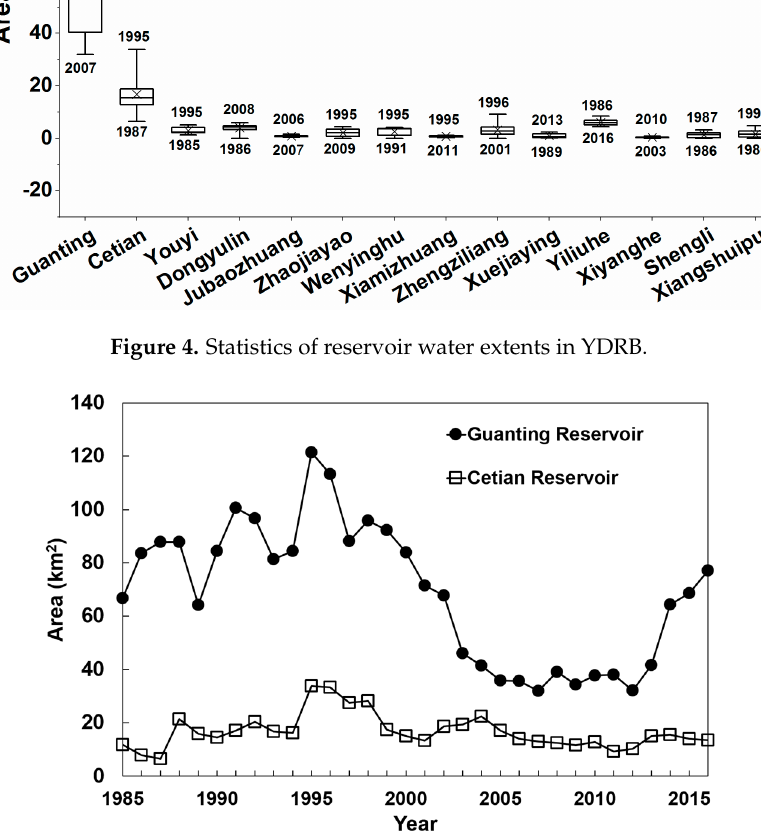
Figure 5. Water extents in the Guanting and Cetian reservoirs.